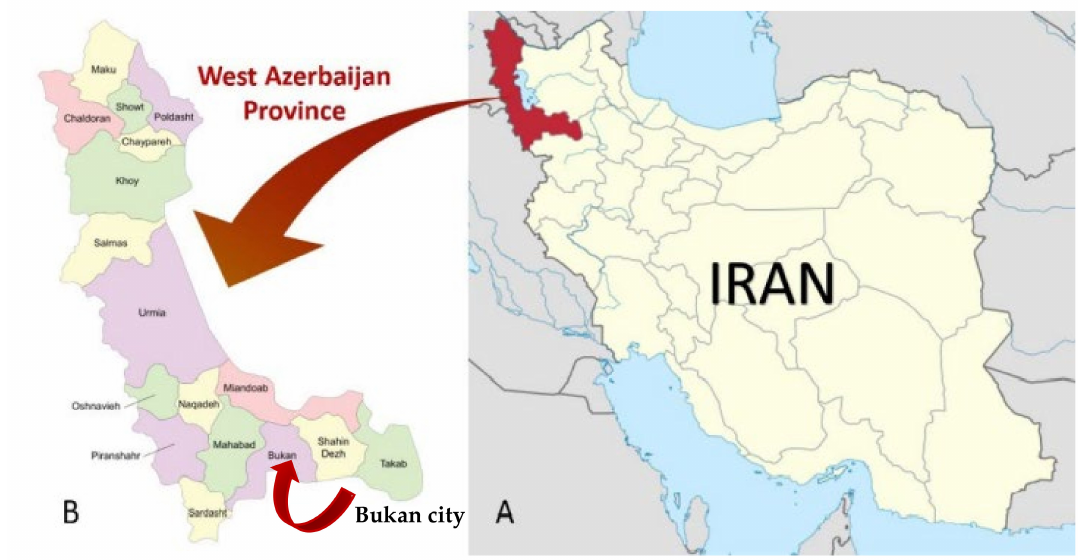
Figure 1. The study area. Source: Nejadrahim et al. [46]. ( A ) : Geographical location of the study area in Iran. ( B ): Geographical location of the study area in West Azerbaijan